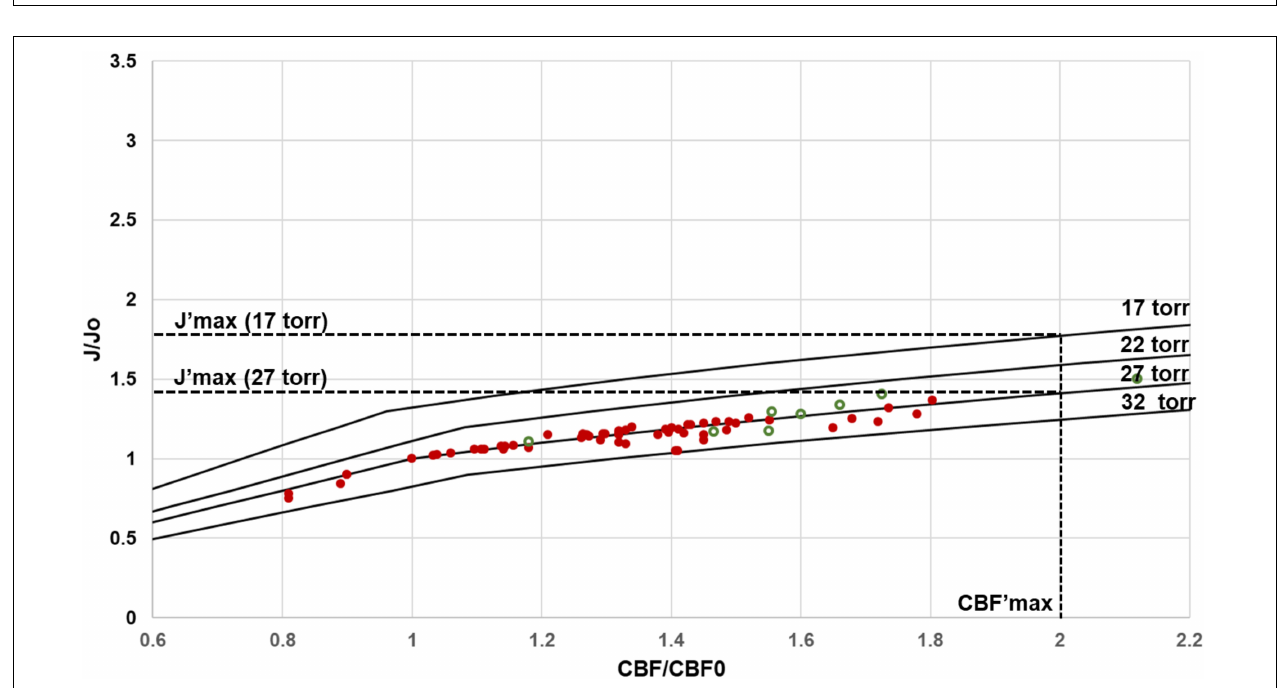
FIGURE 6 | Experimental versus predicted rCBF (cid:48) across the full range of rCMRO 2 . Experimental and predicted values of rCBF (cid:48) according to our model are linearly related with a slope of 0.97 and r 2 = 0.854, indicating that our model accounts for 85.4% of the variation in the experimental data.